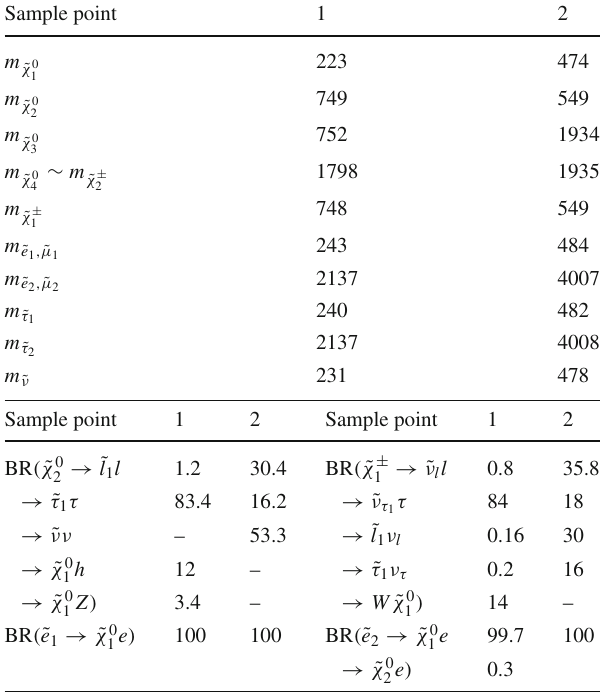
Table 3 The masses (in GeV) and relevant BRs (%) of two sample points from ˜ l ± -coannihilation Case-L scenario. Here we show the BRs of ˜ χ ± and ˜ χ 0 to third generation sleptons separately and that of the first 1 2 two generations together. Therefore, ˜ l refers to ˜ e and ˜ μ together. ν is used to indicate ν e , ν μ and ν τ